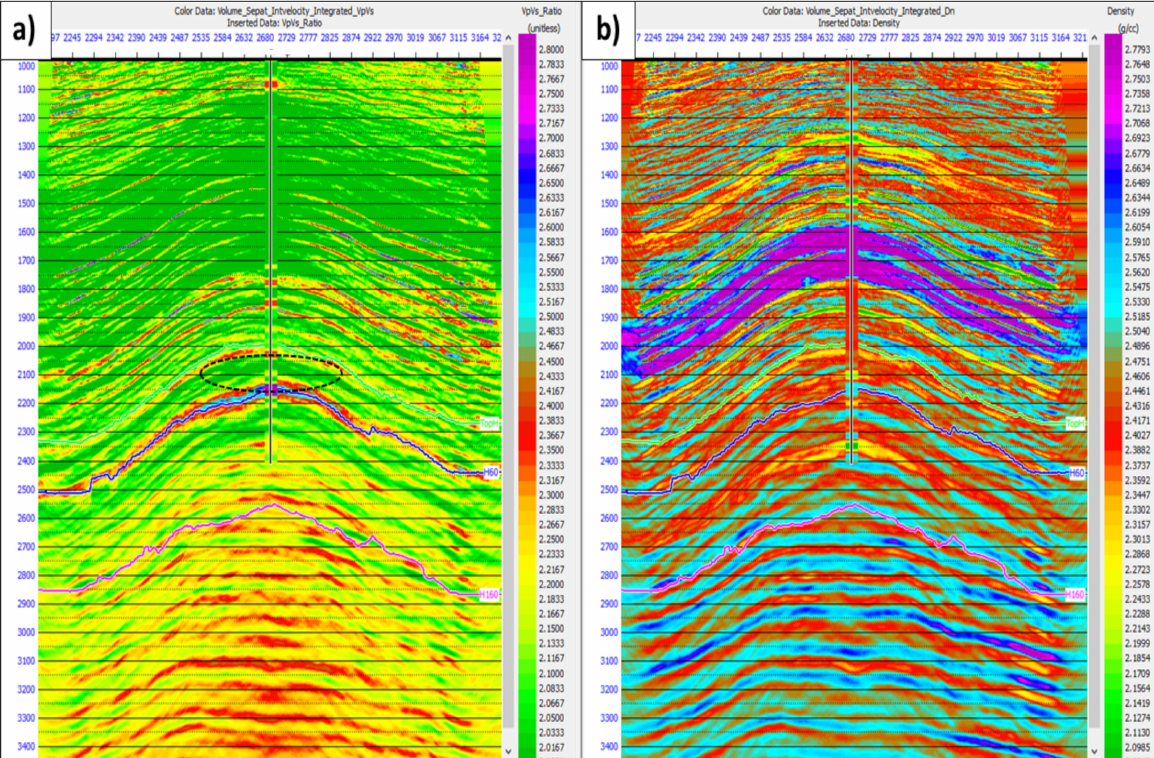
Figure 18. ( a ) Inverted Vp/Vs ratio crossline section containing XD-2 well from pre-stack simultaneous in-version; ( b ) Inverted density crossline section containing XD-2 well from pre-stack simultaneous